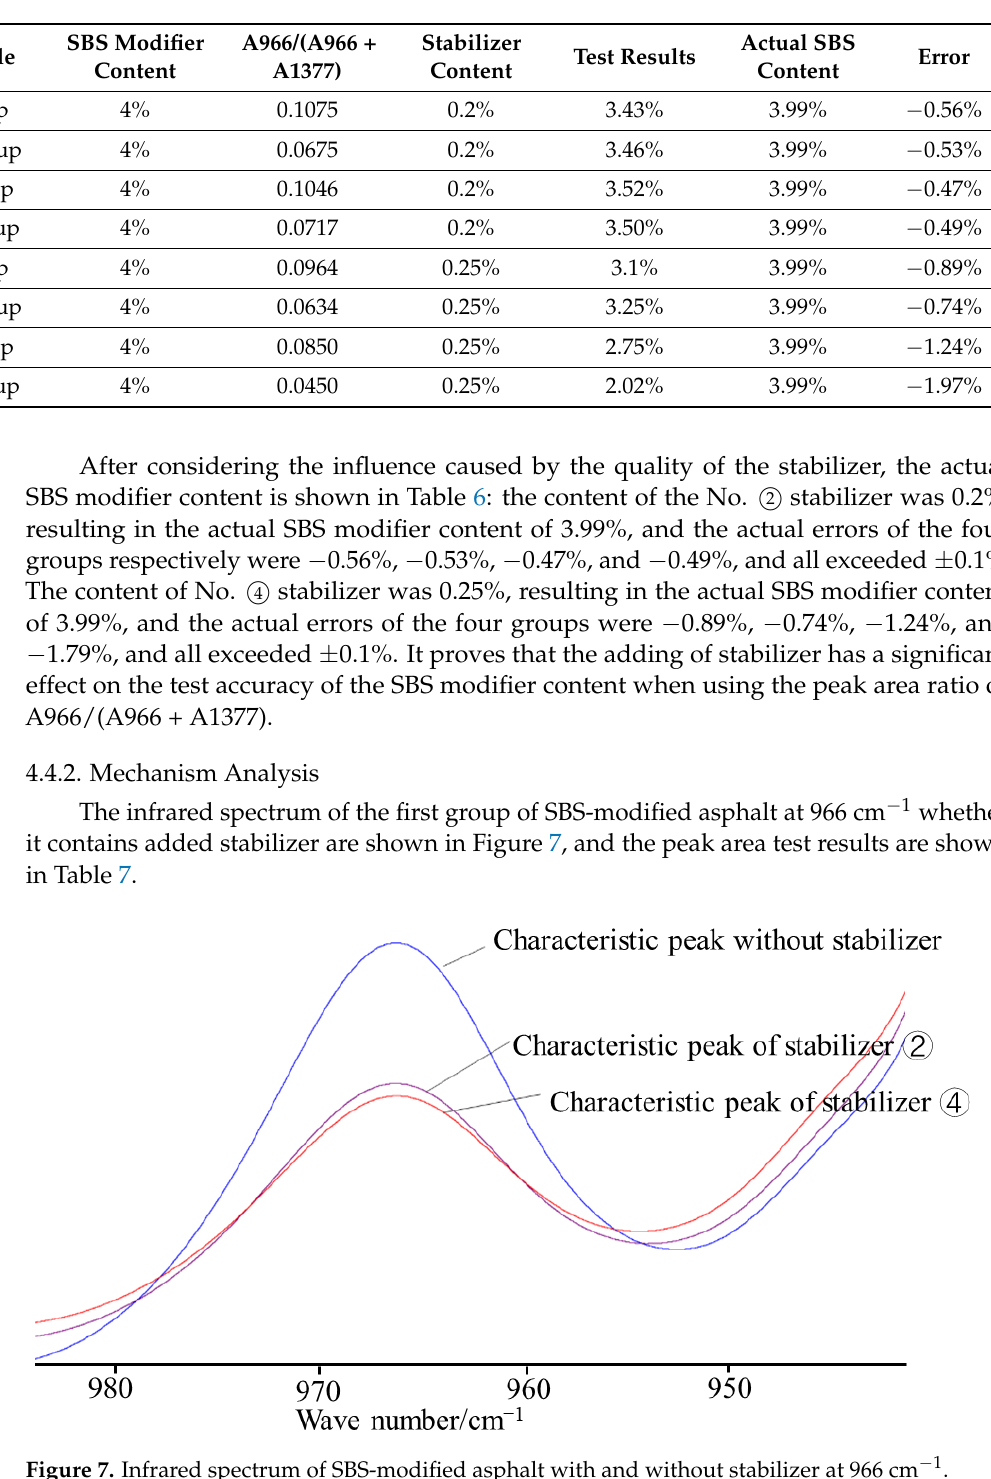
Table 6. Test results of SBS-modified asphalt with stabilizer.